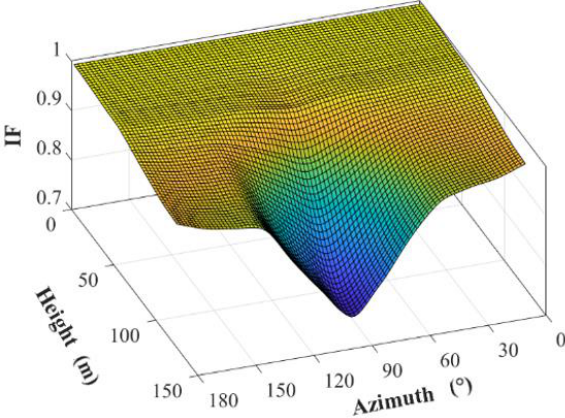
Figure 22. IF for peak deformation of boom-up 3# crane.